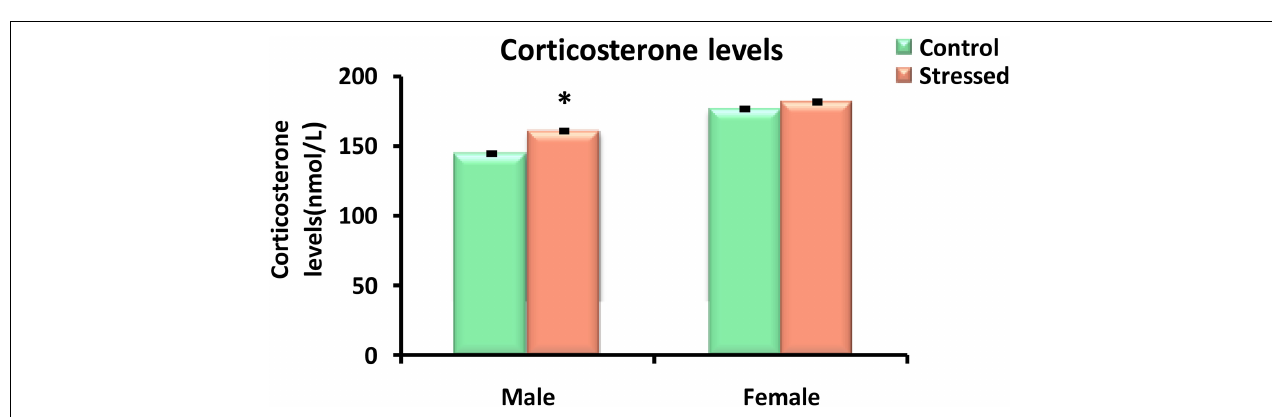
FIGURE 2 | Effect of cold stress on corticosterone levels in male and female rats. Corticosterone was significantly higher in male rats exposed to cold stress compared to their controls. Chronic intermittent cold stress had no significant effect on the corticosterone levels determined in female rats. Data are represented as mean ± SEM ( n = 5) for each sex. Effect of stress: ∗ P < 0.05.